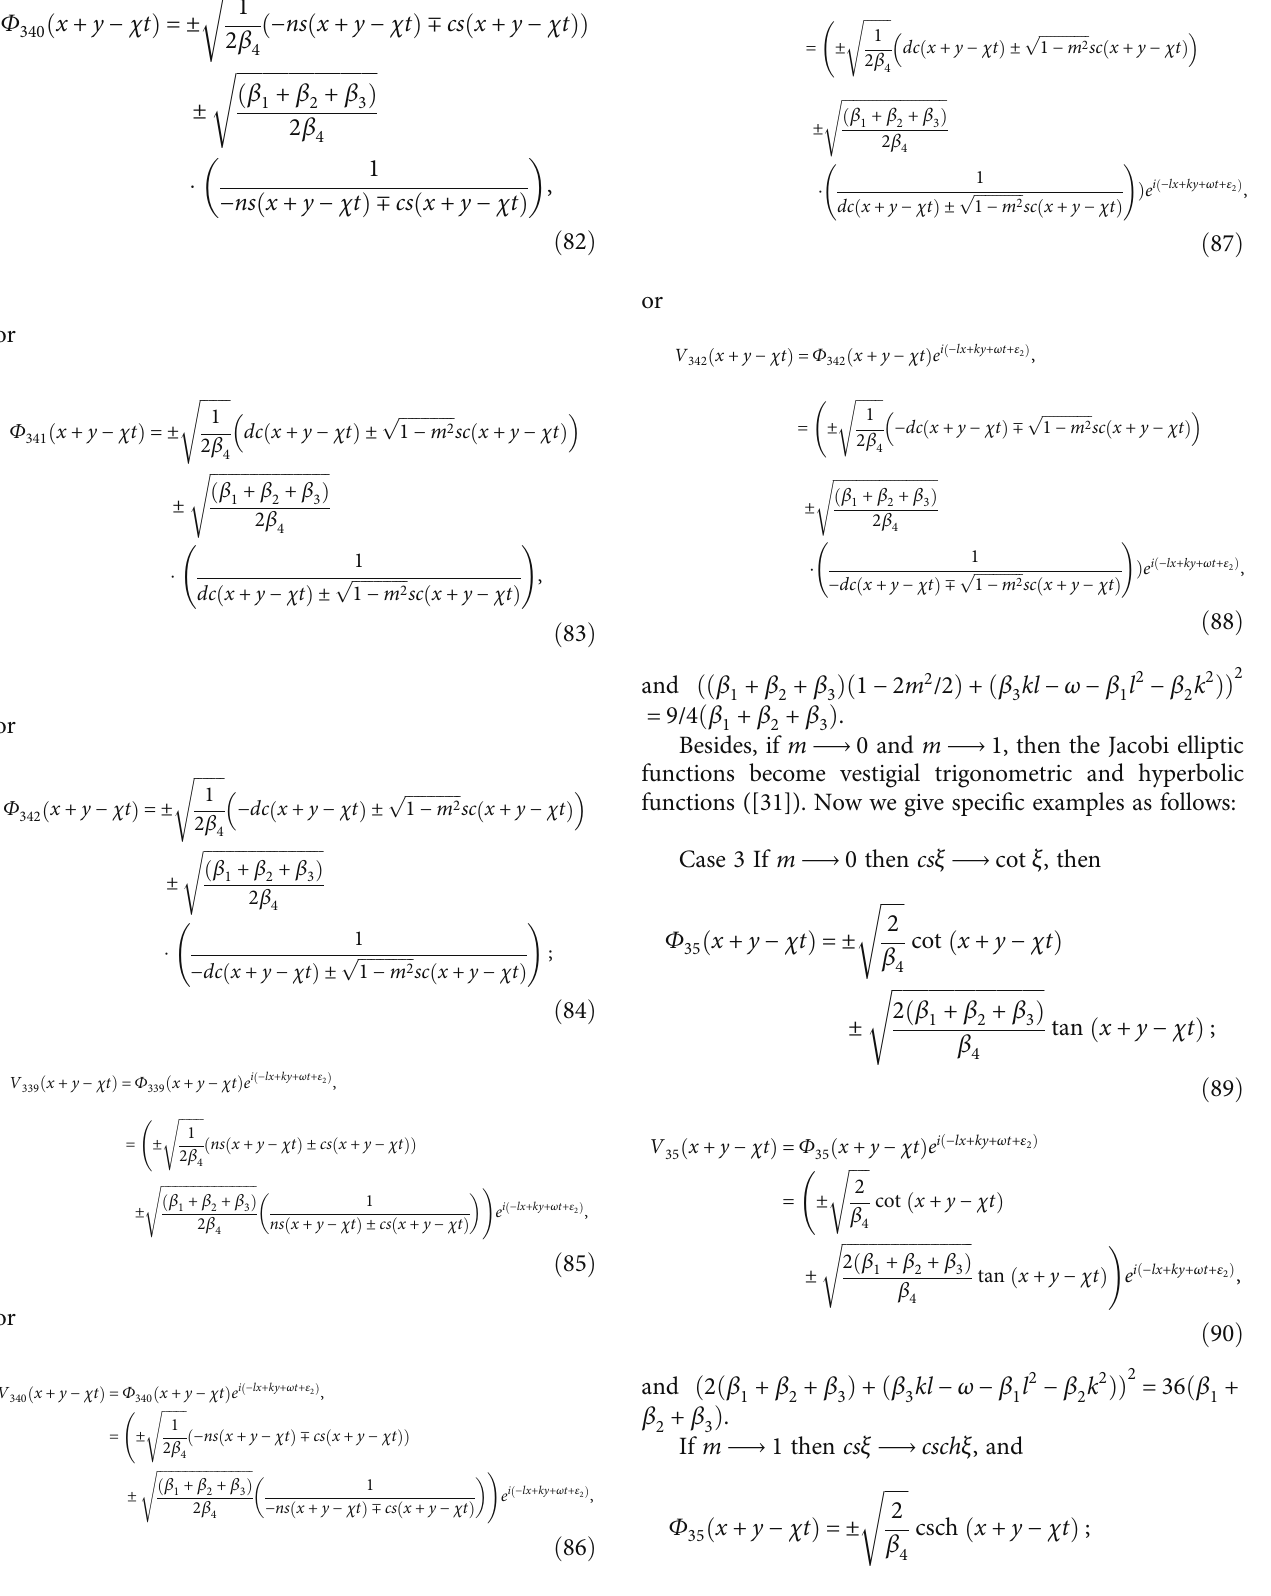
ffiffiffiffiffiffiffiffiffiffiffiffiffiffiffiffiffiffiffiffiffiffiffiffiffiffiffi